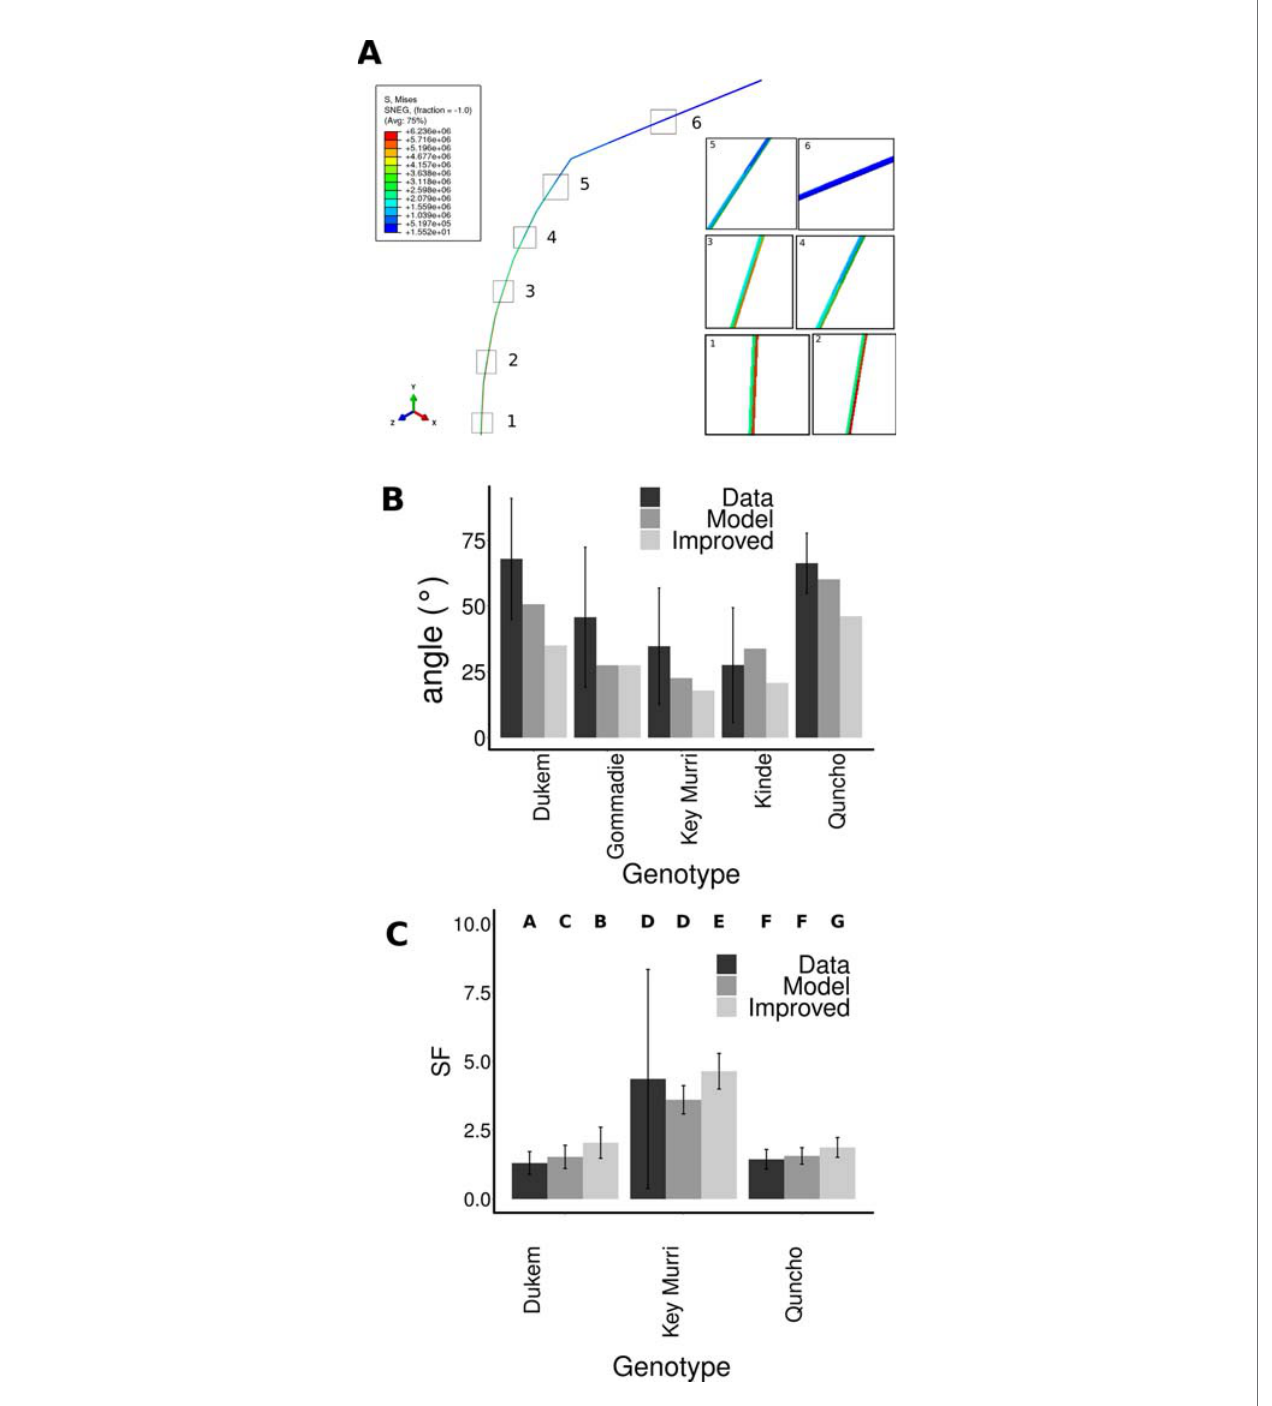
FIGURE 4 | Modeling the lodging angle of different tef genotypes. (A) A simple fi nite element model was constructed, where each internode had the length, mass and elasticity. Gravity was applied to the model, and the base was prevented from moving or rotation. The stress was highest in the lower internodes one and two and lower in the higher internodes three to six. (B) The initial angle of the model was set to the angle of the immature stem before the fl ower emerges. The fi nal angle that the model obtained under the force of gravity was measured (Model), and compared to the measured angles from the fl owering stems (Data). The panicle angle of all genotypes was changed to be that of Gommadie (Improved). This led to an improvement of the lodging of all genotypes especially Dukem and Quncho . (C) The safety factor was compared for the genotypes using the lodging angle as extracted from the data, the model and using the improved model using the Gommadie panicle